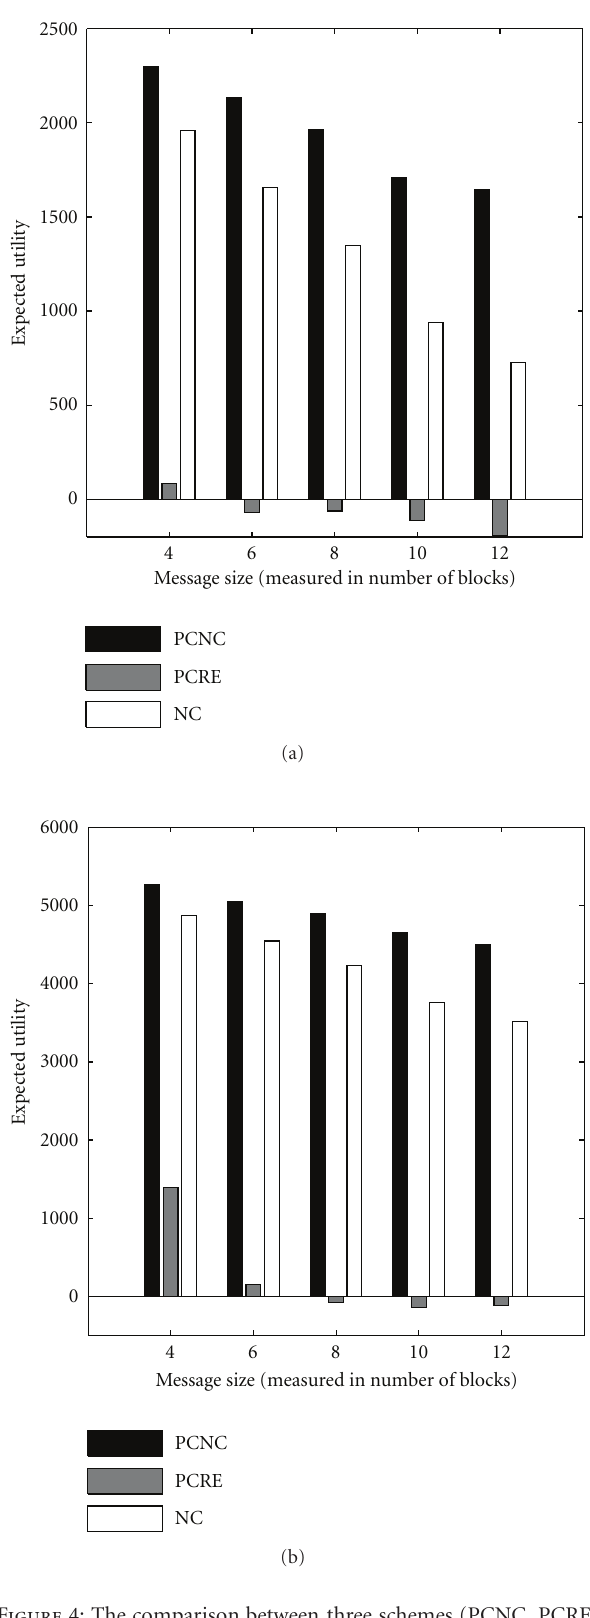
Figure 4: The comparison between three schemes (PCNC, PCRE, and NC) with di ff erent message sizes for unicast routing, when (a) A = 3000 and (b) A =